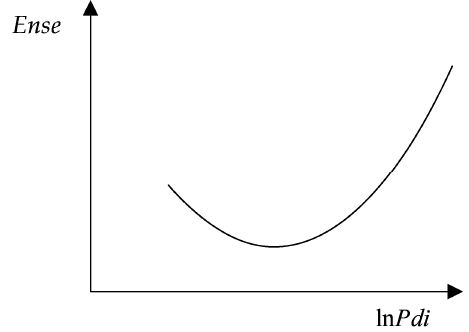
Figure 1. The Kuznets curve relationship between Ense and ln Pdi. Source: Own results.